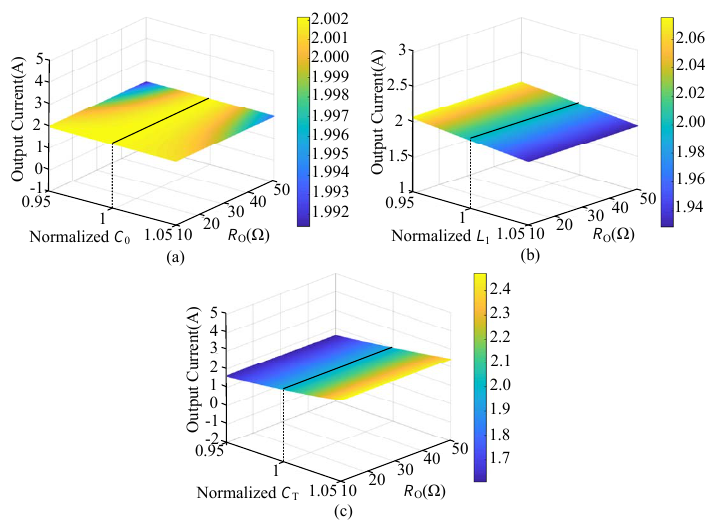
Figure 6. Output current versus different R O and normalized ( a ) C 0 , ( b ) L 1 and ( c ) C T . As evident from Figure 6, the normalized C 0 , L 1 and C T have different effects on the output current of the system. The change of normalized C 0 has almost no effect on the output current, while the changes of normalized L 1 and C T have more or less influence on the output current. Specifically, when the normalized C 0 is adjusted by ± 5%, the output current is almost stable at 2 A and remains unchanged. When the normalized L 1 is adjusted ± 5%, the change rate of output current is between ± 3%. When the normalized C T is adjusted by ± 5%, the change rate of output current is within ± 20%. The above verification results show that the output current has the lowest sensitivity to the compensation capacitance C 0 . Therefore, by adjusting the value of C 0 , the ZVS operation can be achieved without affecting the CC output characteristic of the